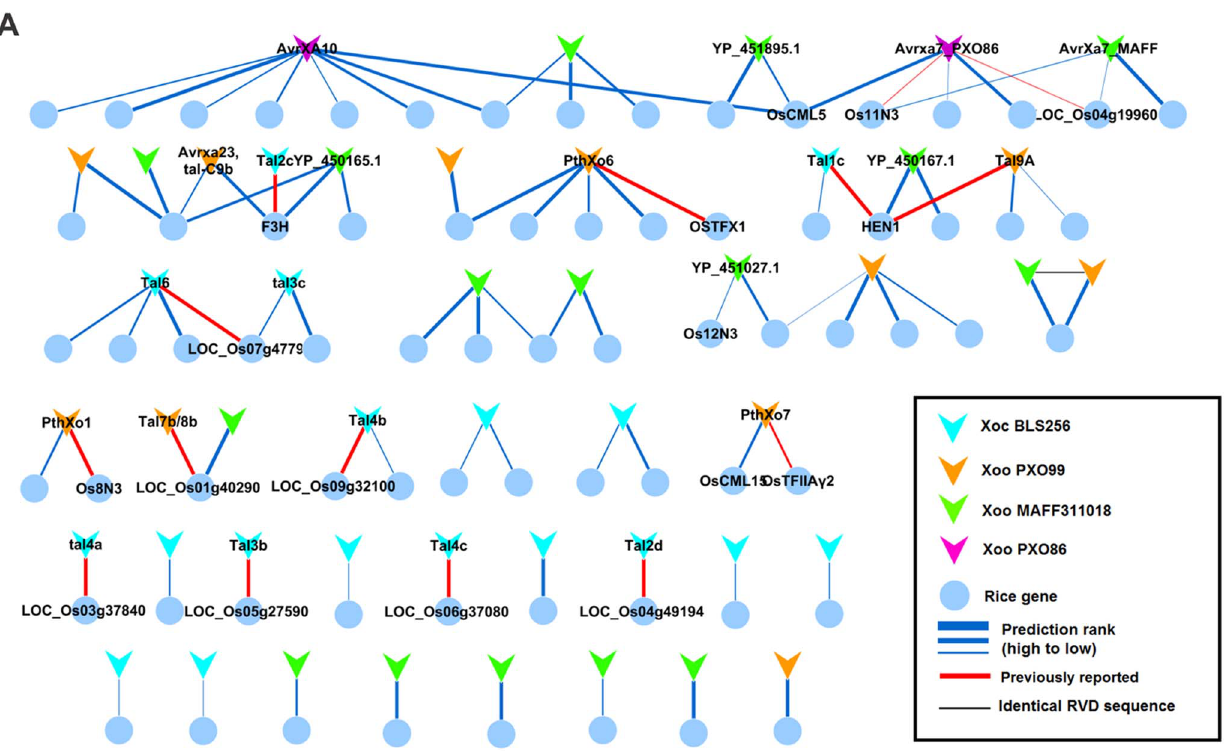
Figure 4. A TALE-candidate target gene network. Hierarchical representation of the TALE-candidate target gene network; genes are represented by circles and TALEs by polygons. Only the names of genes and targets discussed in the main text are shown. Alias or common names for TALEs are shown when available or the GeneBank accession number is given instead. Increasing edge thickness indicates better EBE prediction ranking. Interactions previously reported in the literature are highlighted with red edges. (Figure 6), indicating that internal genetic redundancy among TALEs targeting MtN3/SWEET family members may be a